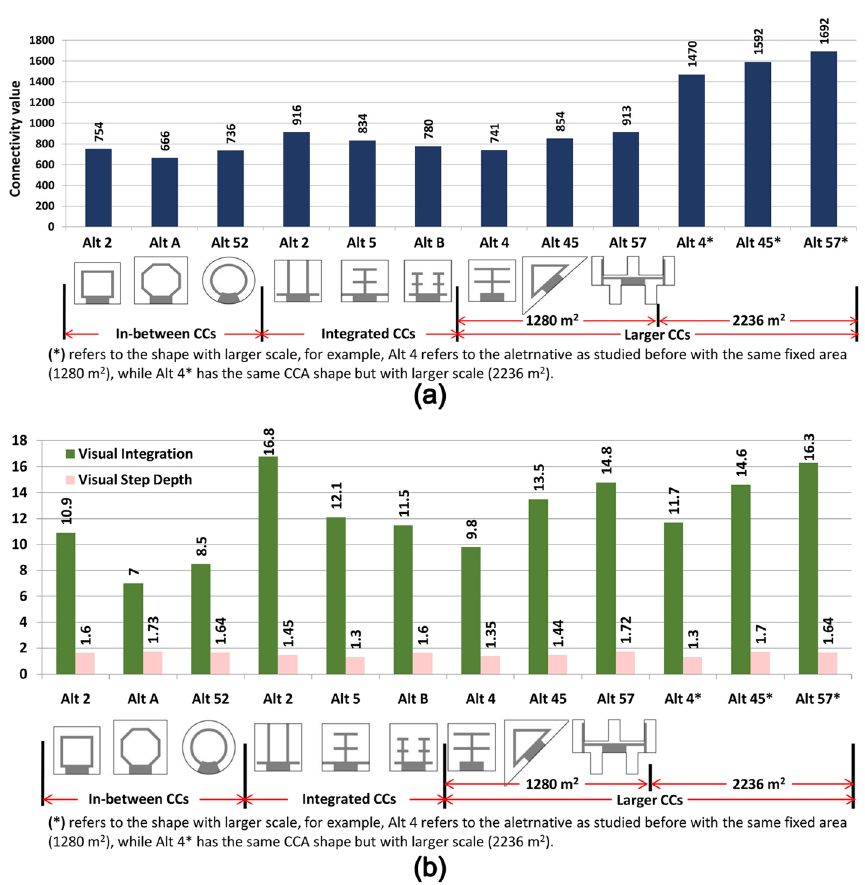
Fig. 7 Results of in-between, integrated, and scaled CCAs out of basic ones: a Connectivity. b VI and